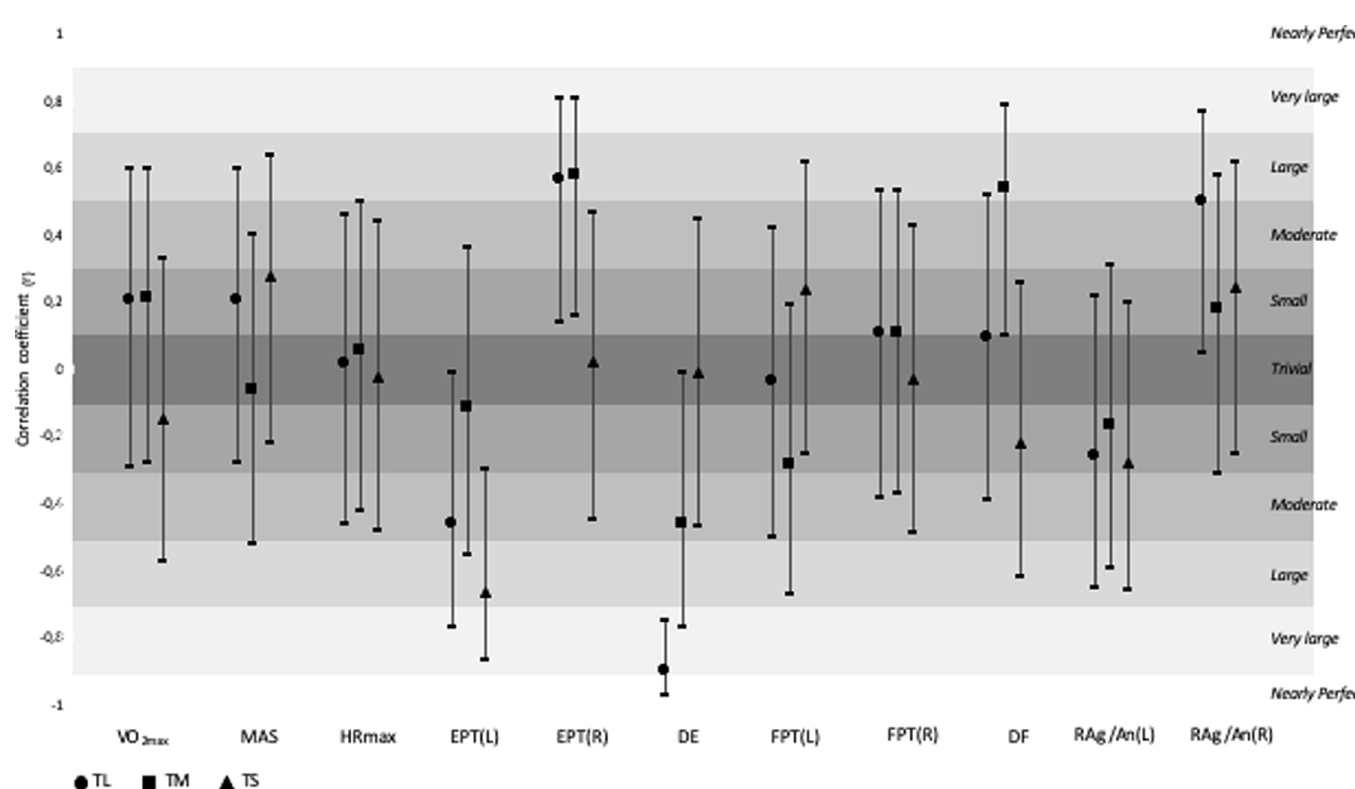
Fig 4. Correlation coefficients (90%CI) of sum of training load (TL), sum of training monotony (TM) and sum of training strain (TS) with % of differences (pre- post) of fitness variables.